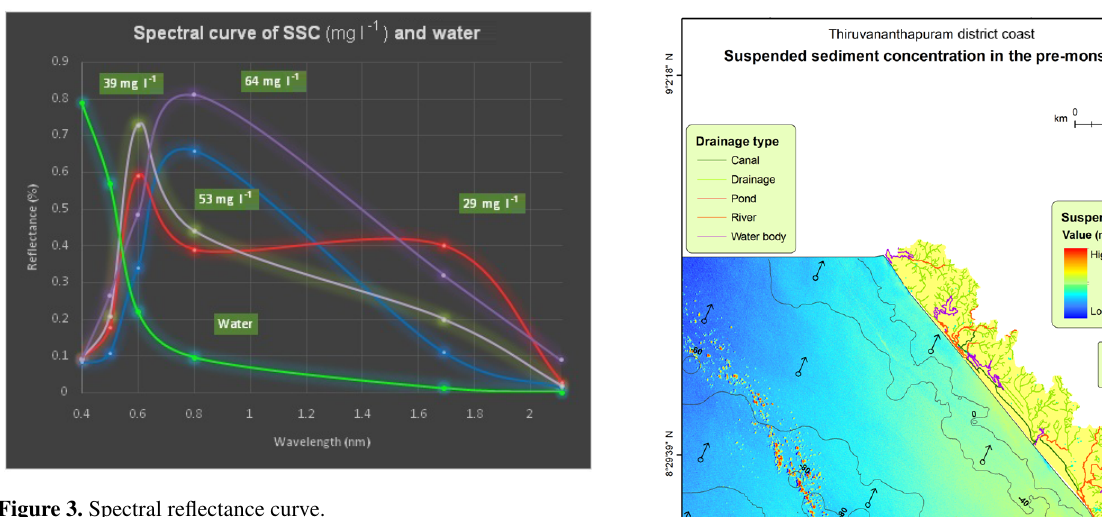
Figure 3. Spectral reflectance curve.